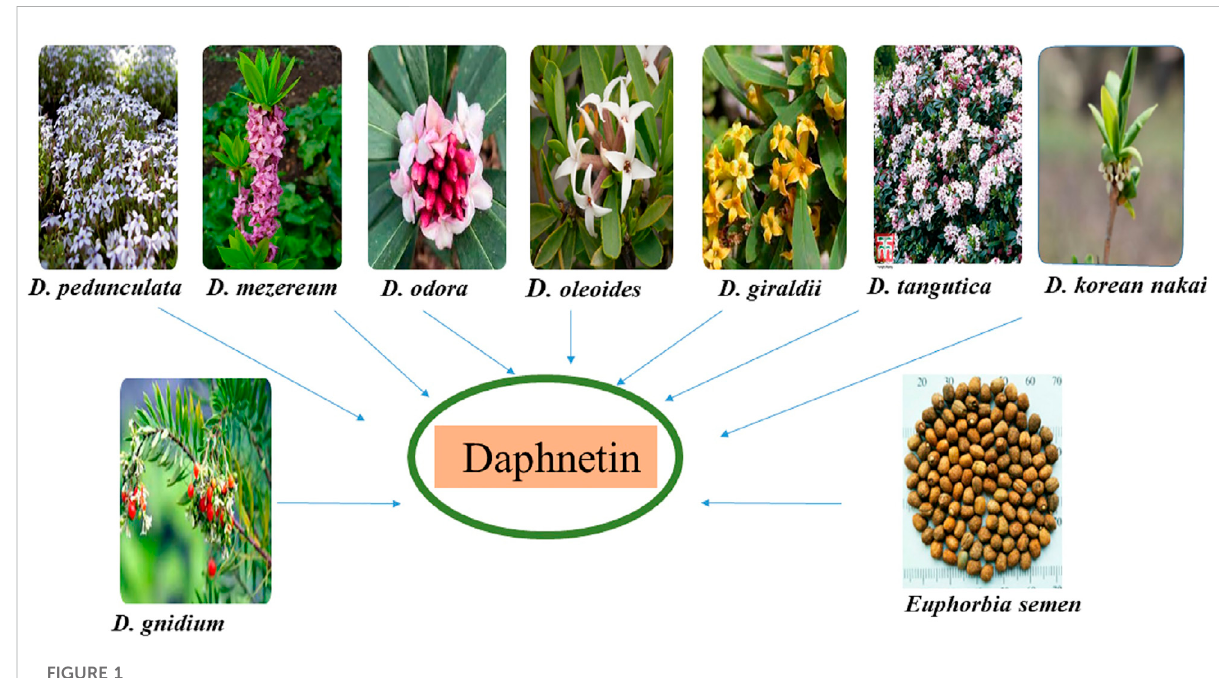
FIGURE 1 Different sources of